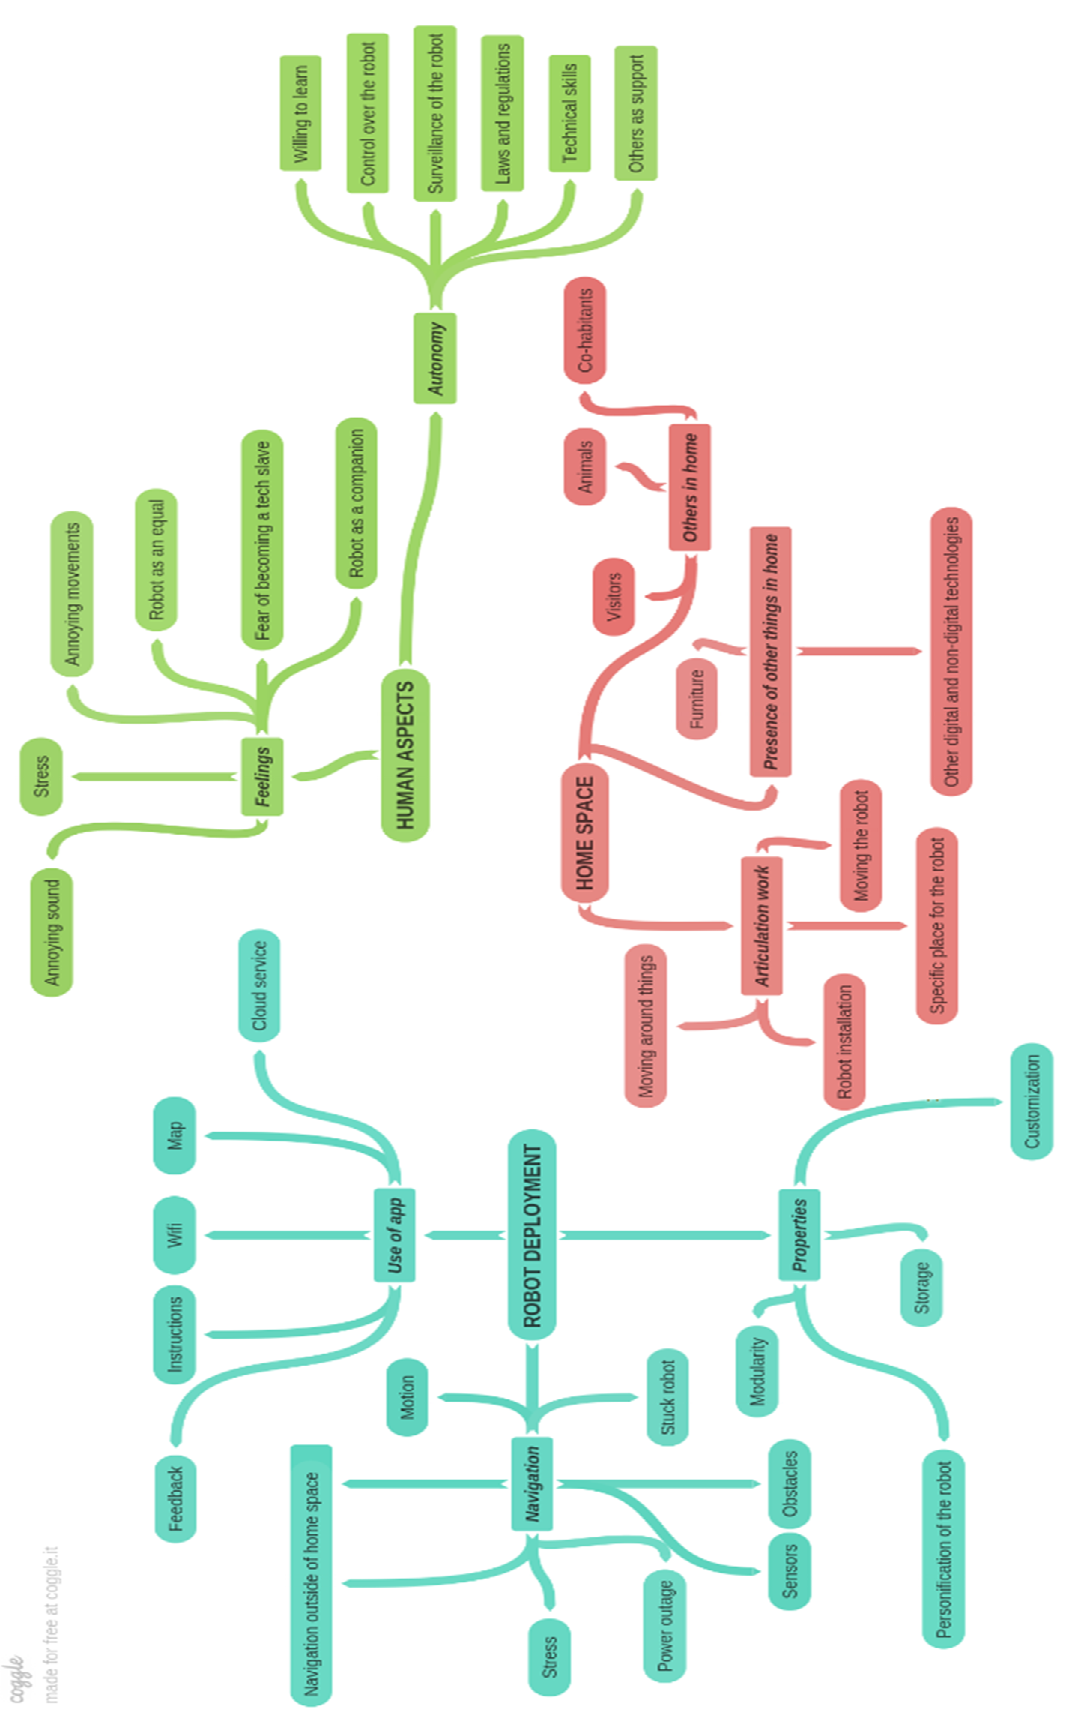
Figure 2. Final themes emerged from the data analysis.